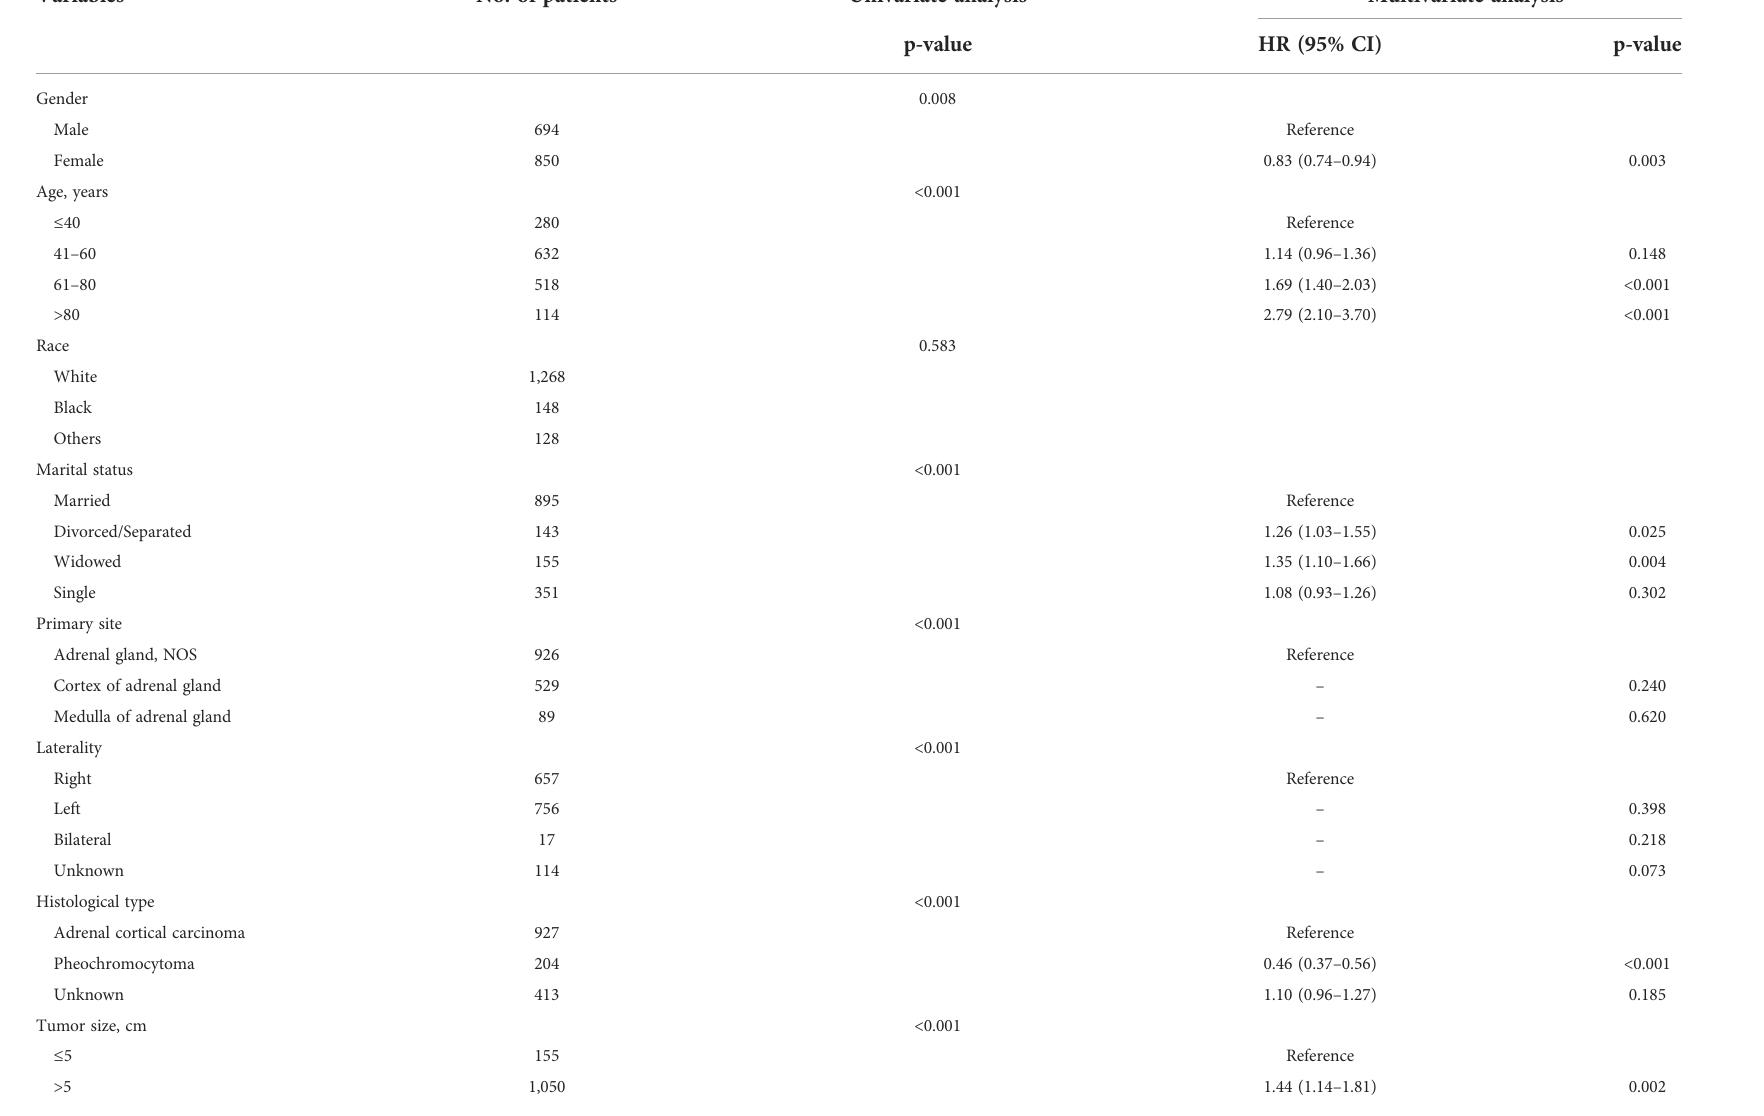
TABLE 2 Univariate and multivariate analysis of overall survival (OS) rates in the training